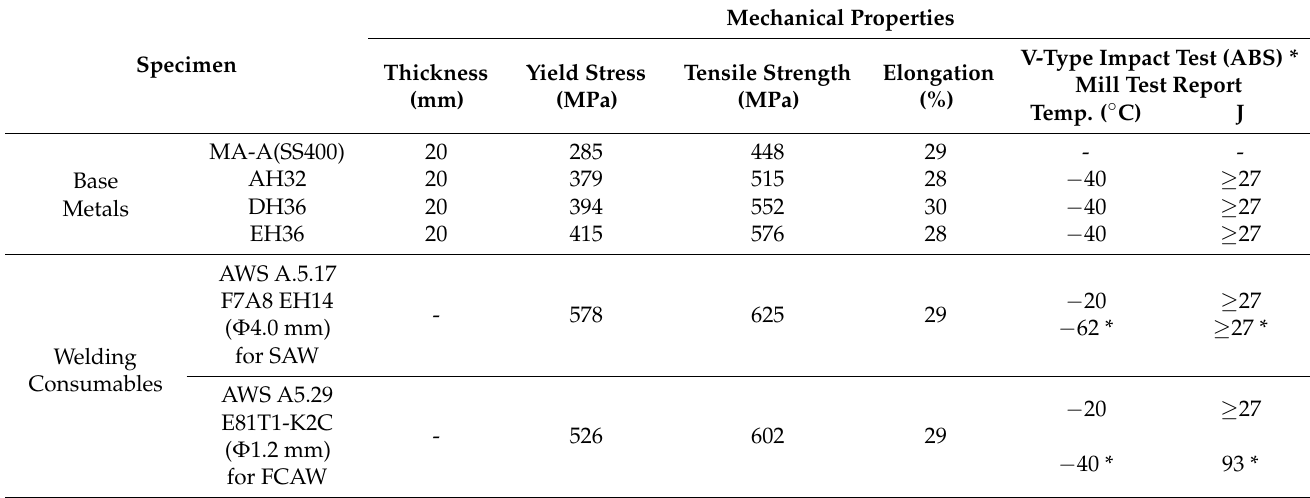
Table 2. Mechanical properties and requirements of base metals and welding consumables.